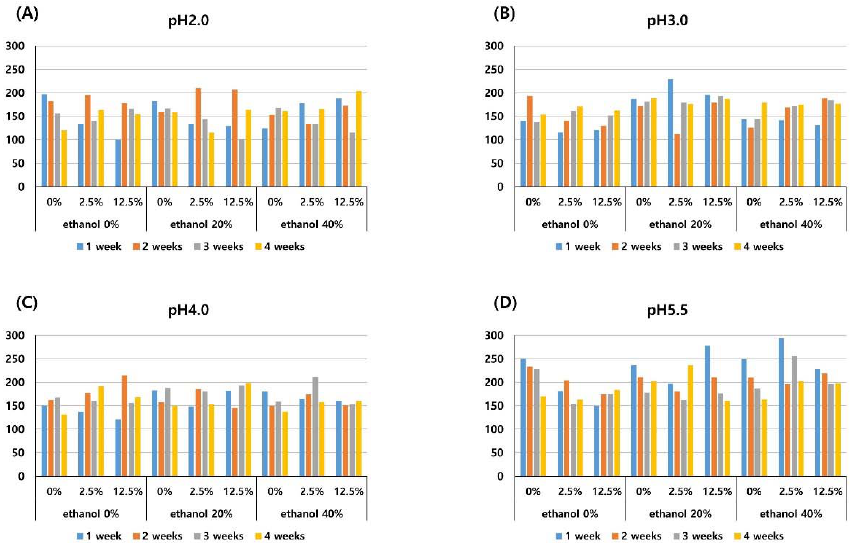
Figure 4. Mean microhardness values of the composite resin after different periods of storage (1-, 2-, 3-, and 4-weeks) in media of pH 2.0 ( A ), pH 3.0 ( B ), pH 4.0 ( C ), pH 5.5 ( D ) with three different pigment concentrations (0%, 2.5%, 12.5%), and three different ethanol concentrations (0%, 20%, 40%).